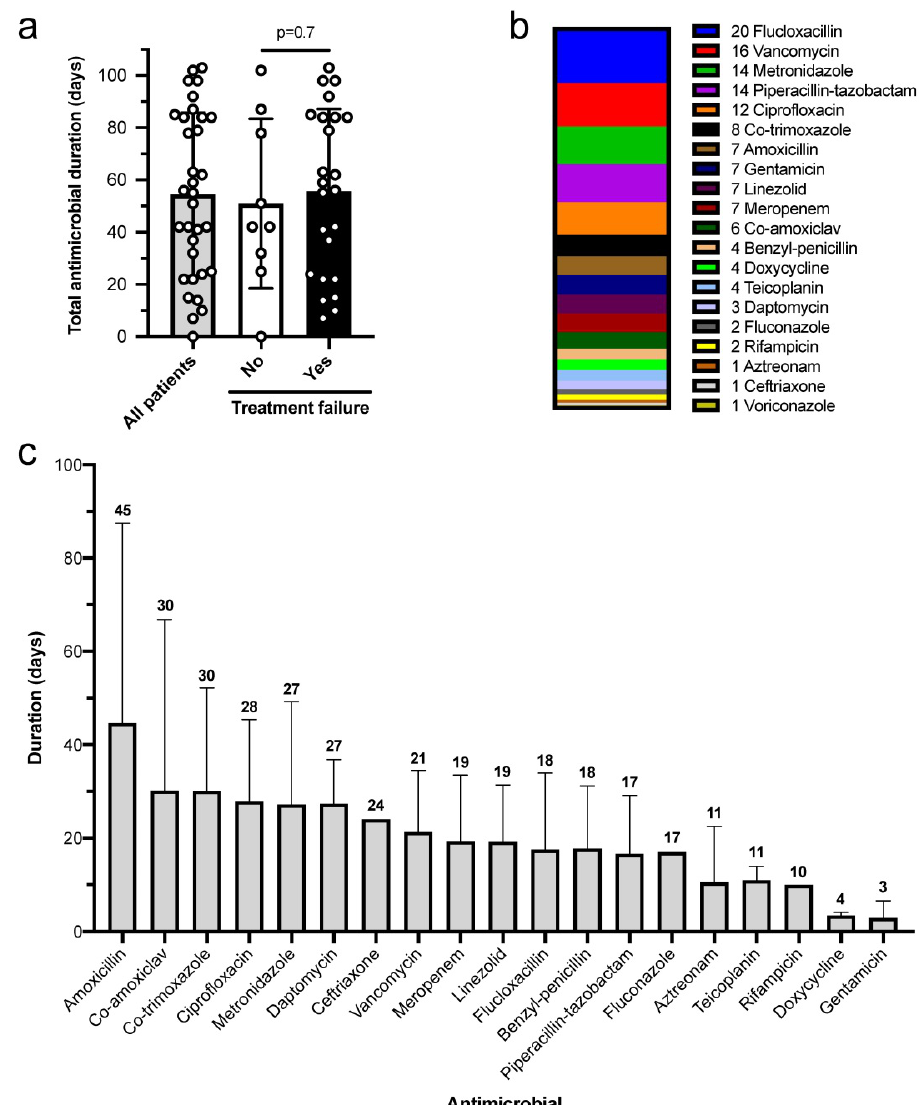
Figure 1. Antimicrobial usage. a) The total antimicrobial duration at index presentation was not associated with subsequent treatment failure (groups compared by unpaired t test). b) Antimicrobial agents used during management of index episode. c) Duration of each antimicrobial agent during index episodes (number is mean). Antimicrobial data available for 33 patients. Graphs show mean and standard